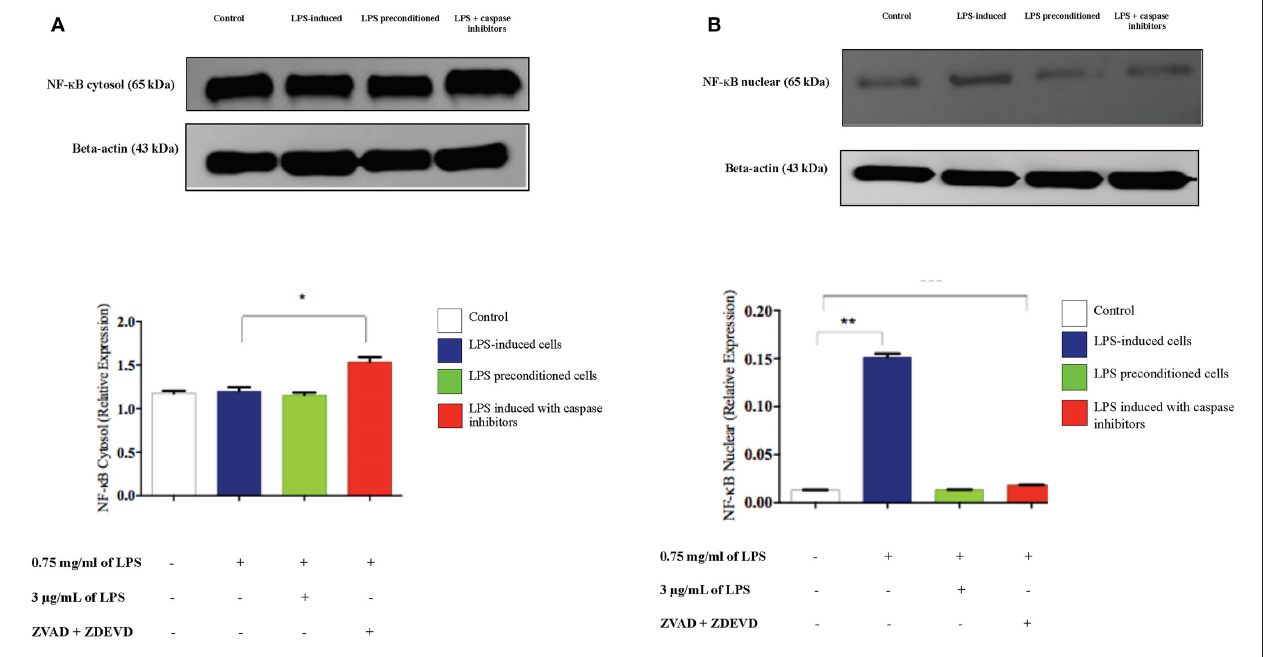
FIGURE 20 | Analysis of cytoplasmic and nuclear expression of NF- κ B by western blot. The cytoplasmic (A) . and nuclear (B) . NF- κ B in LPS-induced cells, LPS-pre-conditioned cells, and LPS-induced cells with caspase inhibitors from the cell lysates. The expressions were determined by western blot. Band densities were measured by densitometric analysis, and data for the expression of cytoplasmic and nuclear NF- κ B was normalized to the control while the expression was expressed as fold change relative to beta-actin. Bars represent data from three independent experiments. NF- κ B expression in LPS-induced cells, LPS-preconditioned cells, and LPS-induced cells with caspase inhibitors was compared to control. * p < 0.05 and ** p < 0.01, as determined by one-way ANOVA with Bonferroni’s